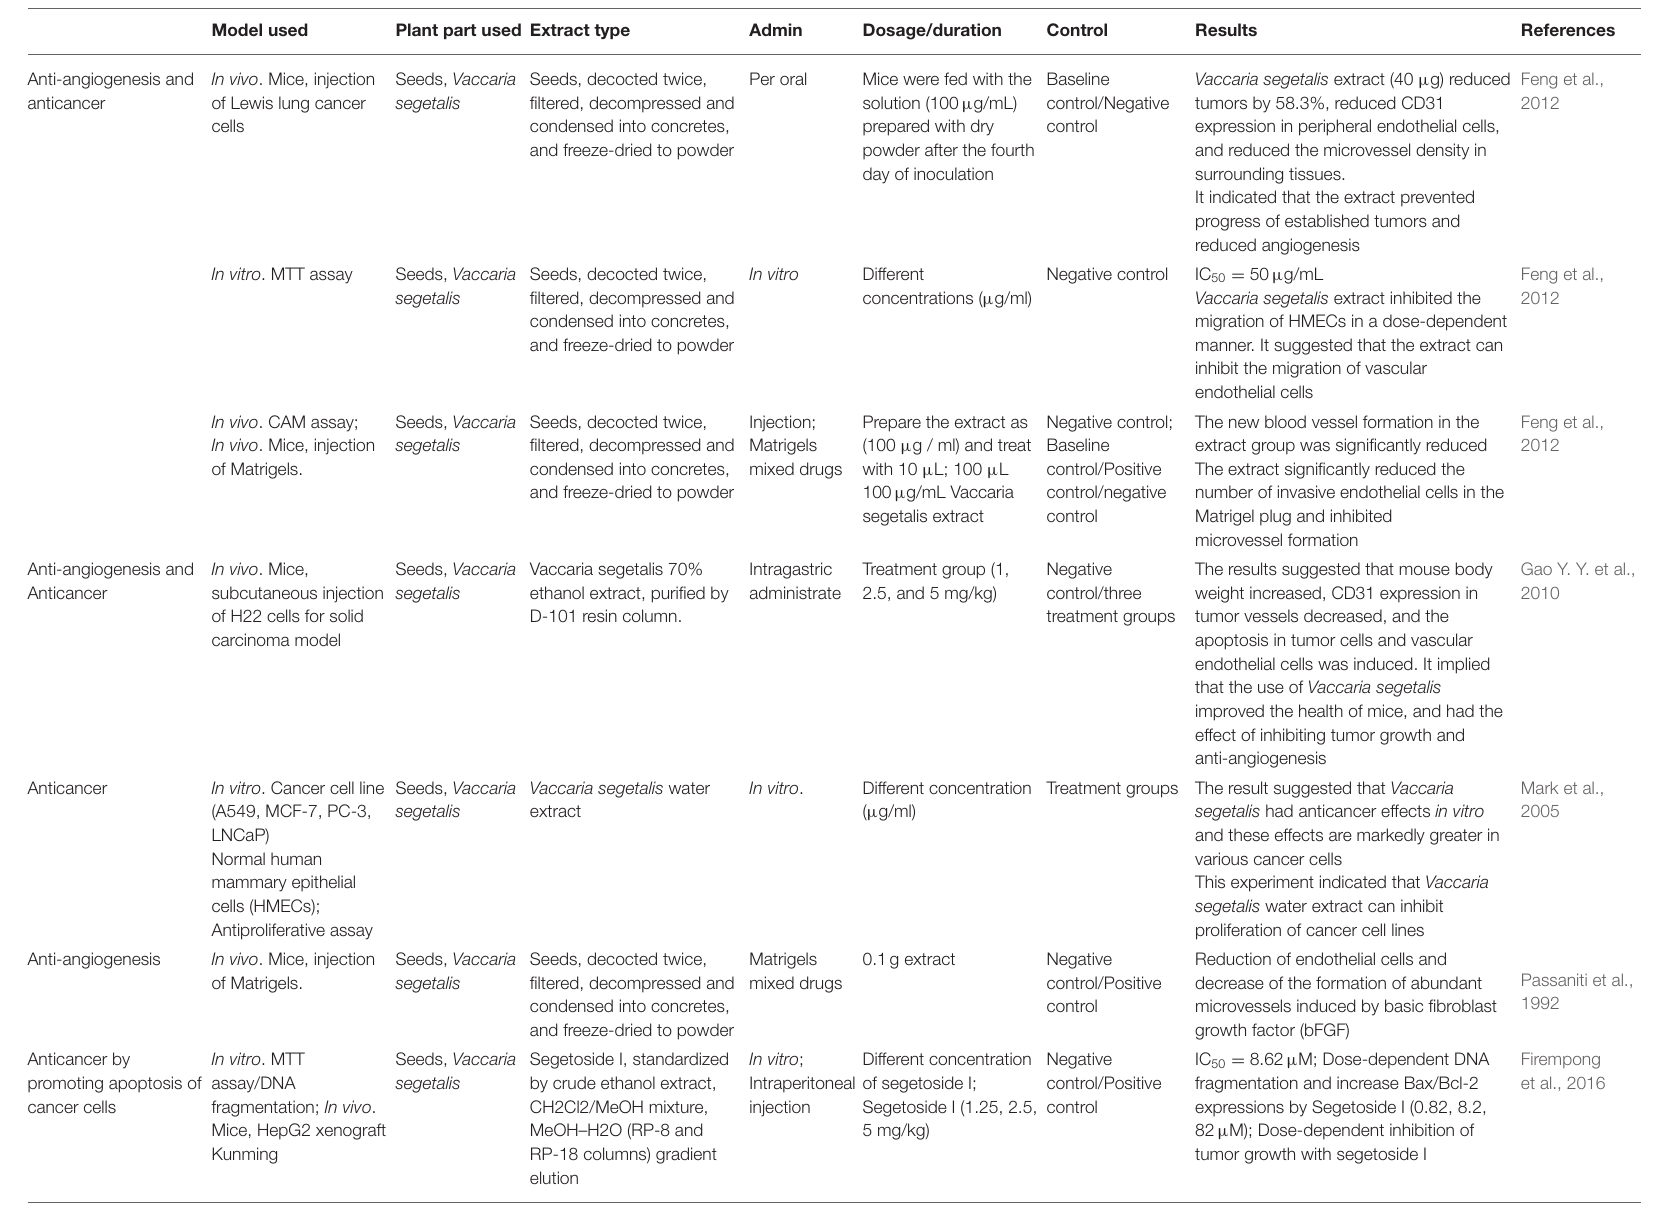
TABLE 3 | Anticancer activity of V. segetalis